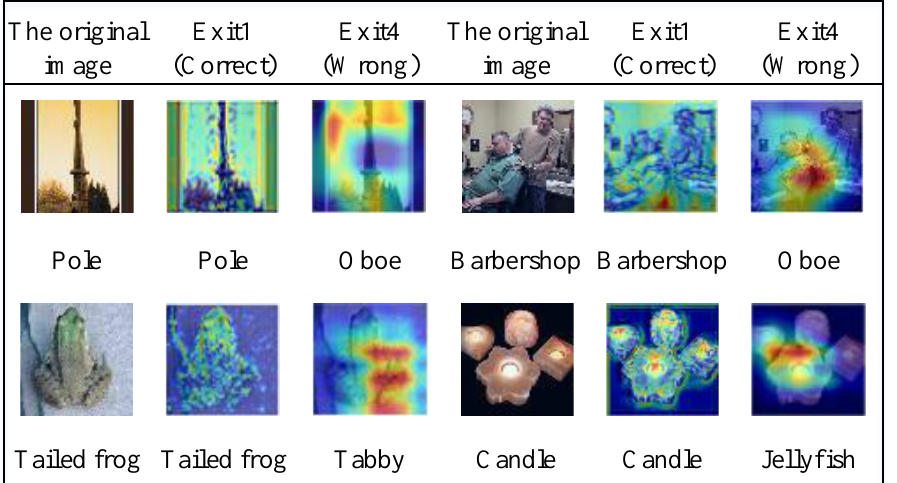
Figure 5. A set of Tiny ImageNet samples with only the first exit classified correctly in the case of a teacher–student architecture of ResNet34–ResNet18, and heat maps drawn with Grad-CAM. Below the original image column is the true label for that sample, and below each sample in each exit column is the predicted category label for that